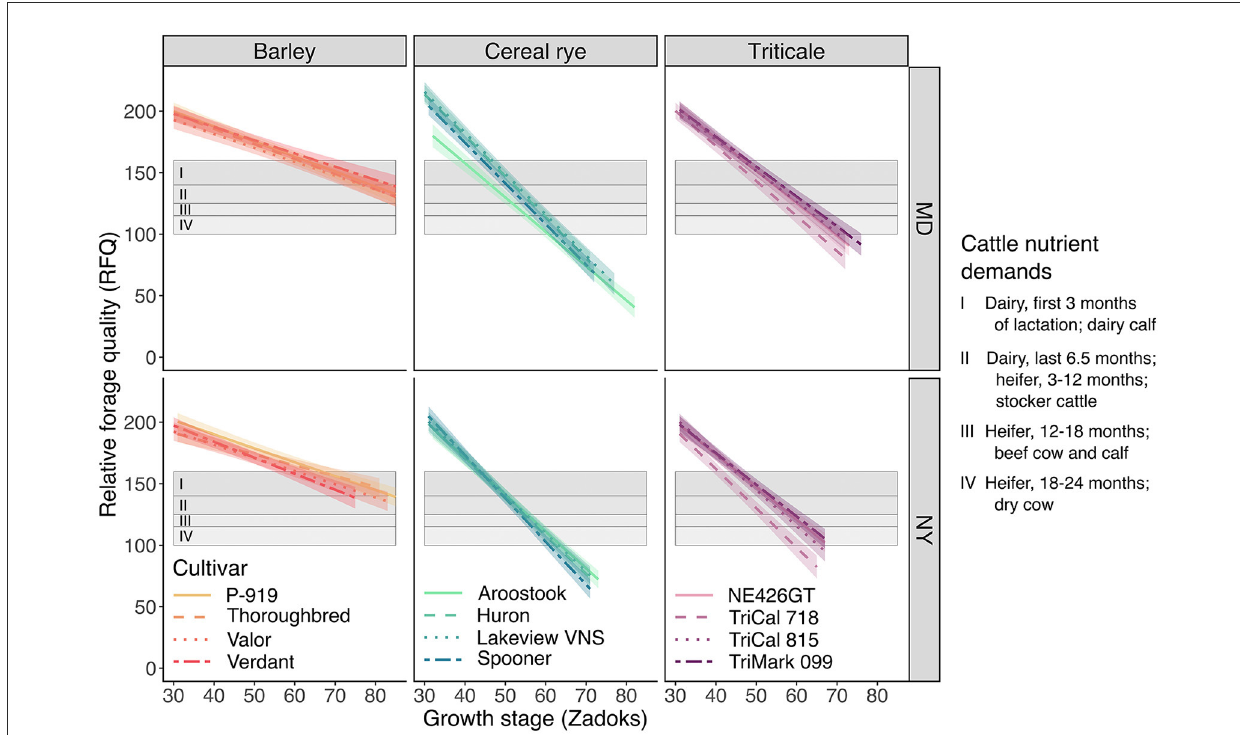
FIGURE3 The effect of winter cereal cultivar (four per species), growth stage (Zadoks), and site (MD and NY) on relative forage quality. The shaded “ribbon” accompanying each cultivar slope (line) represents a 95% confidence interval. Shaded rectangular areas indicate the recommended forage quality as it relates to the specific nutrient demands of an animal: (I) dairy cow (first 3 months of lactation) or dairy calf, RFQ 140–160; (II) dairy (last 6.5 months), heifer (3–12 months), or stocker cattle, RFQ 125–150; (III) heifer (12–18 months) or beef cow and calf, RFQ 115–130; and (IV) heifer (18–24 months) or dry cow, RFQ 100–120 (adapted from Ball et al., 2008). The ranges presented here show the minimum RFQ for each group (I–IV) to the minimum of the next group (with the exception of group I, as there is no group that has higher quality demands); the maximum values, which overlap with the next group (with the exception of group I), are not depicted in the shaded areas. Analysis of variance and coefficients of determination for this linear mixed-effects model are presented in Table